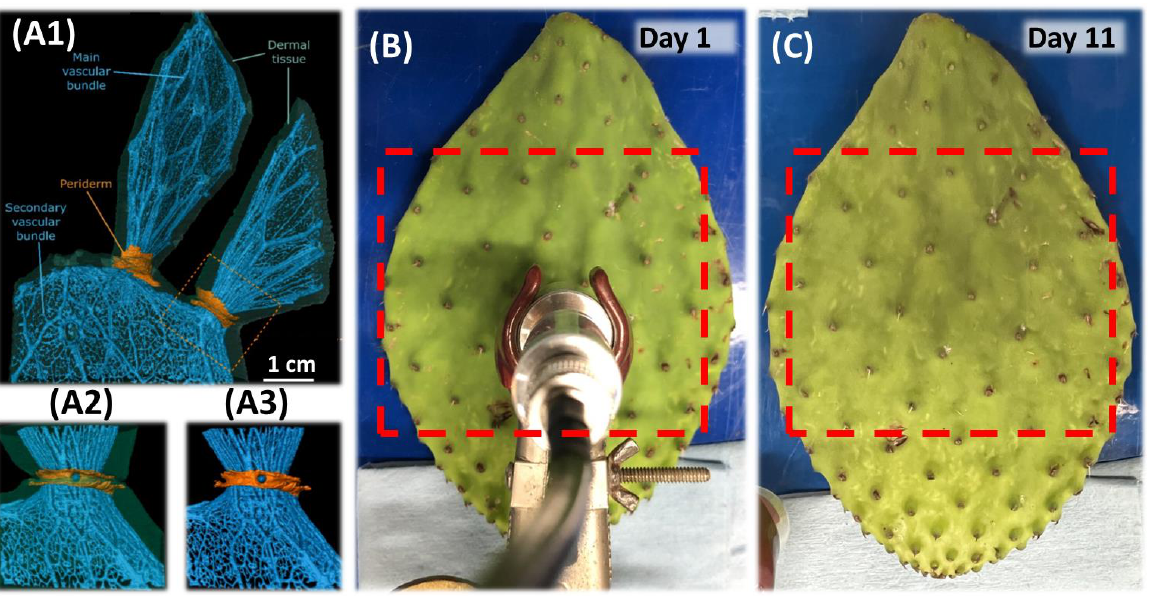
Figure 2. MRI scans of Opuntia ficus-indica (prickly pear) from reference [38]: ( A1 ) overview scan includes vascular system (blue), dermal tissue (transparent green), and peridermal tissue (orange). The web-like structure of the vascular is clearly shown in the figure; ( A2 ) surface coil scan with dermal tissue; ( A3 ) surface coil scan without dermal tissue; ( B , C ) photographs of the scanned cactus sample at the start of the monitoring (day 1) and end of monitoring (day 11), with the red boxes indicating the EBME scanned areas on the sample.